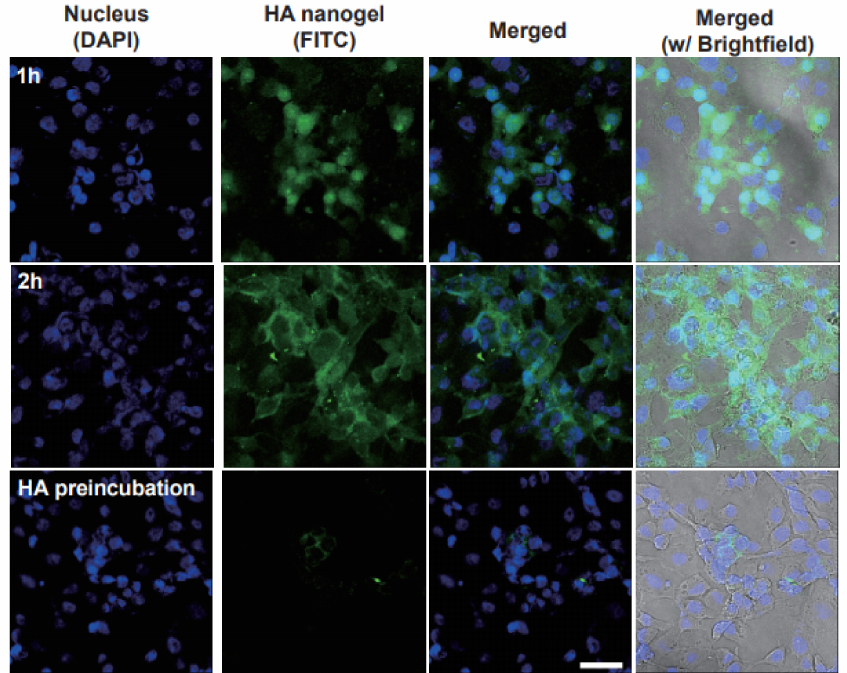
Figure 4. In vitro confocal microscopic analysis of FITC-encapsulating HA nanogels uptaken to B16F1 cells after 1 h ( top ) and 2 h ( middle ) of incubation, and the competitive binding test with HA preincubation ( bottom ). Scale bar indicates 50 µ